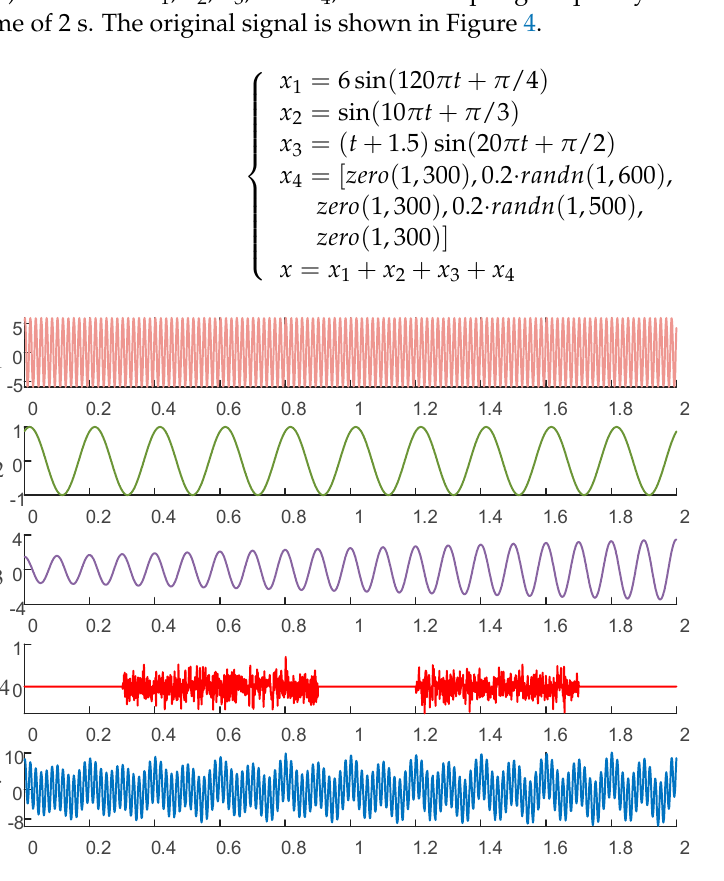
Figure 4. The original simulation signal.